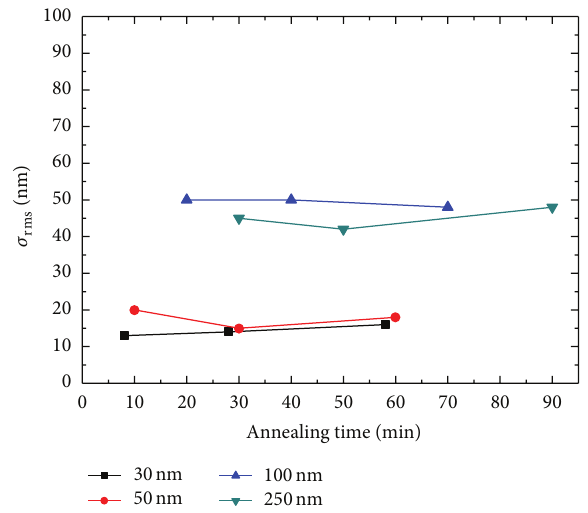
Figure 1: 𝜎 values estimated from AFM over 15 × 15 𝜇 m 2 images rms for different annealing time and Al